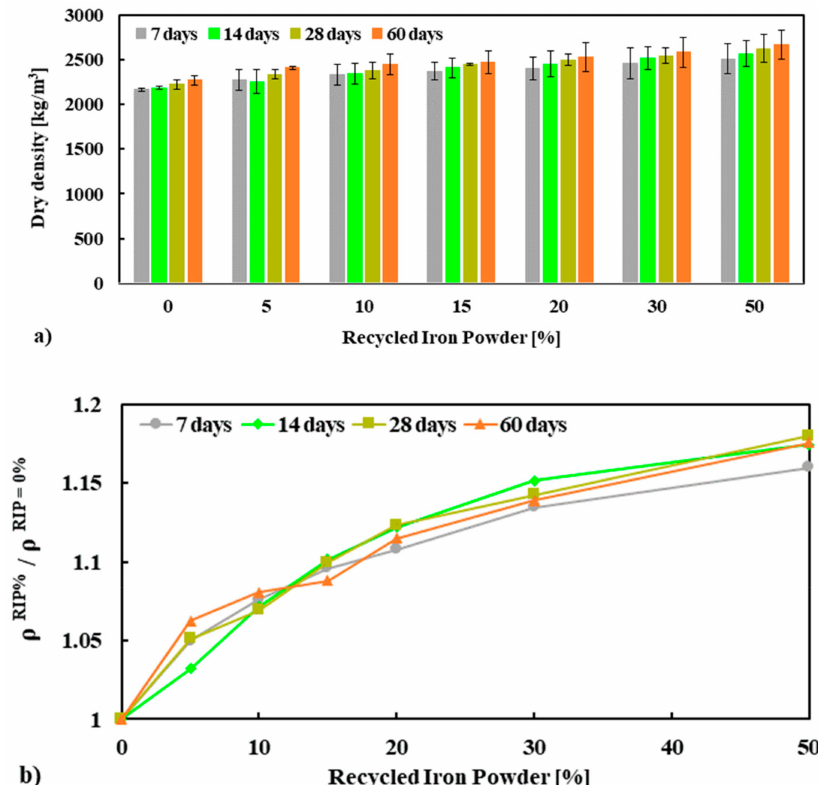
Figure 3. Dry density ( ρ ) ( a ) and normalized ρ ( b ) of mortars as a function of RIP content conducted at 7, 14, 28 and 60